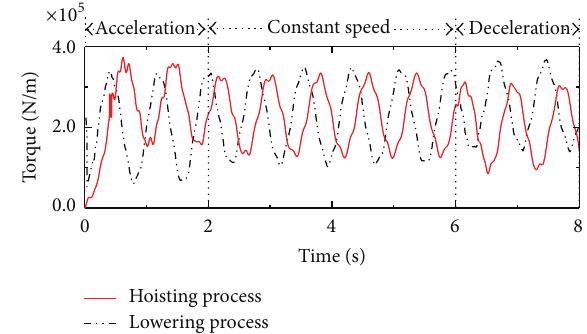
Figure 6: Hoisting dynamic load torque of gear transmission